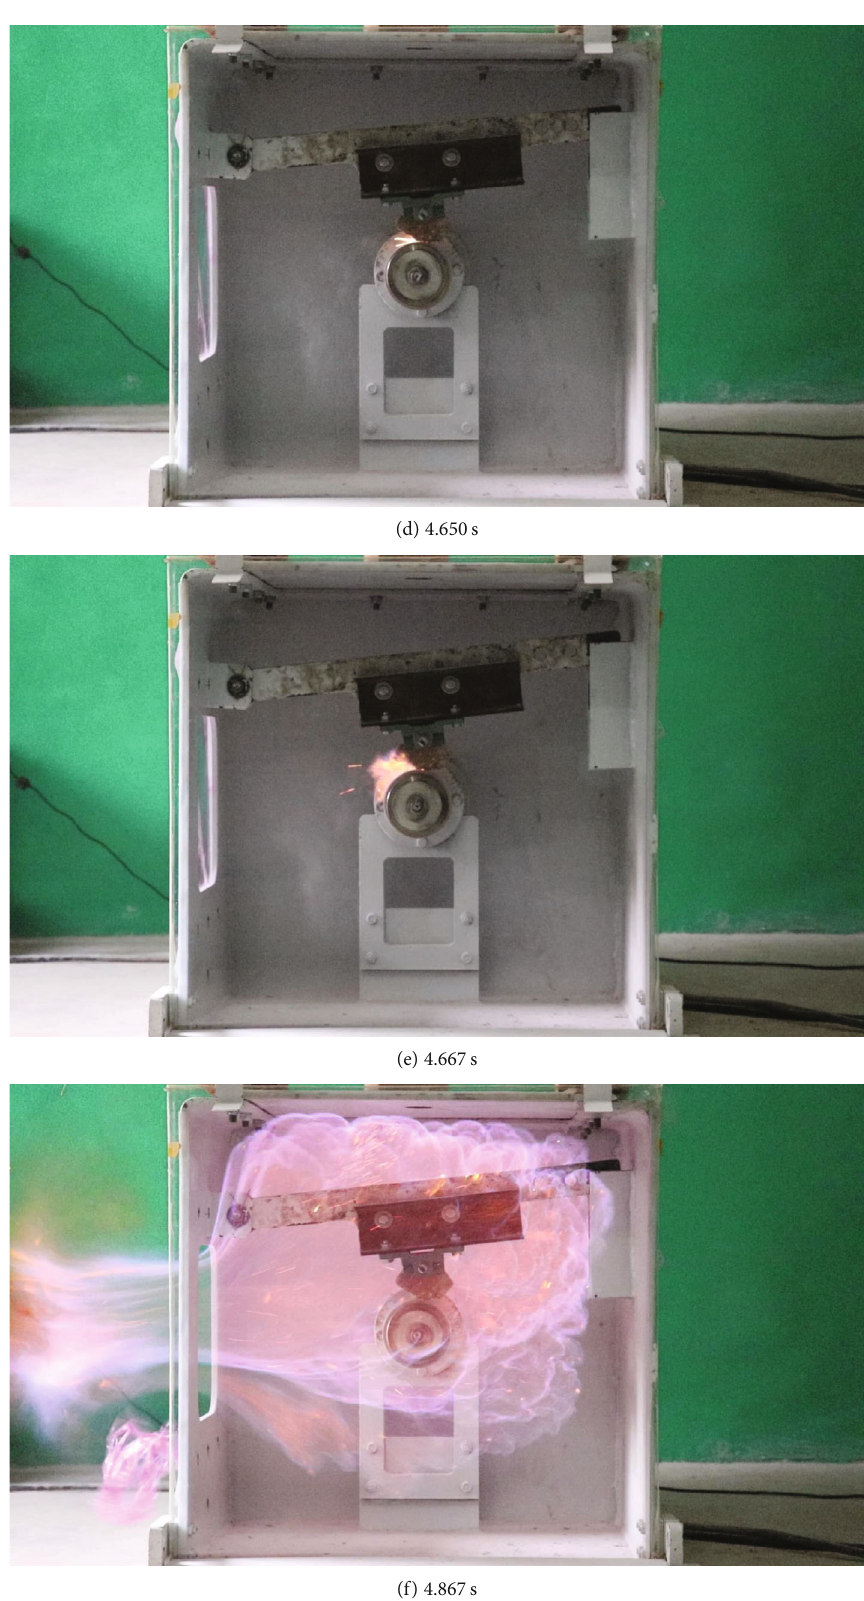
Figure 4: Process of hard sandstone friction spark inoculation and gas